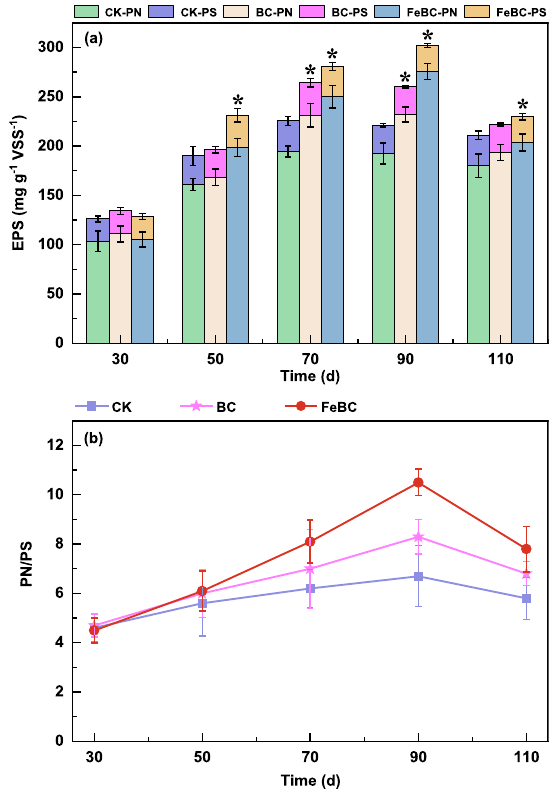
Fig. 5 The variations of proteins (PN), polysaccharides (PS) content ( a ) and protein to polysaccharide ratio (PN/PS) ( b ) in three anammox system extracellular polymeric substances (EPS) during a long operation process. Asterisks indicate significance ( P < 0.05)